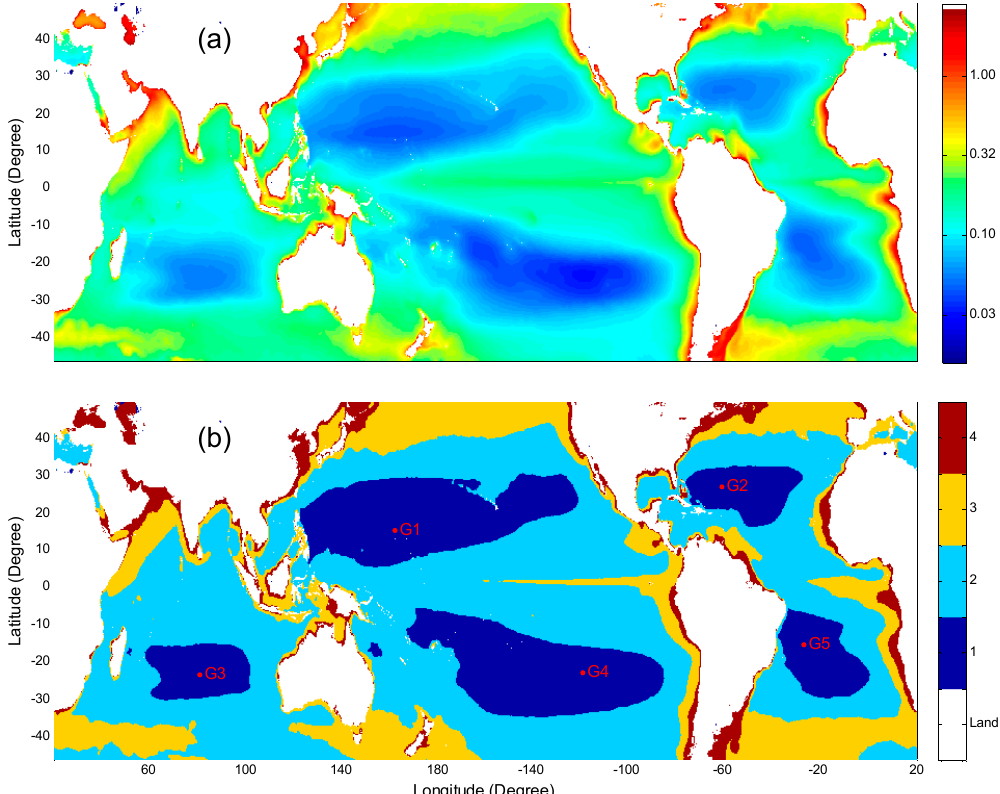
Figure 2. ( a ) The average of Chl-a in the unit of mg / m 3 . ( b ) Regions classified by the averaged Chl-a values with Class 1 ( < 0.07 mg / m 3 ), Class 2 ( ≥ 0.07 and < 0.2 mg / m 3 ), Class 3 ( ≥ 0.2 and < 0.5 mg / m 3 ), and Class 4 ( ≥ 0.5 mg / m 3 ). The five sites G1–G5 are the centers of the oligotrophic gyres with the lowest values of Chl-a.